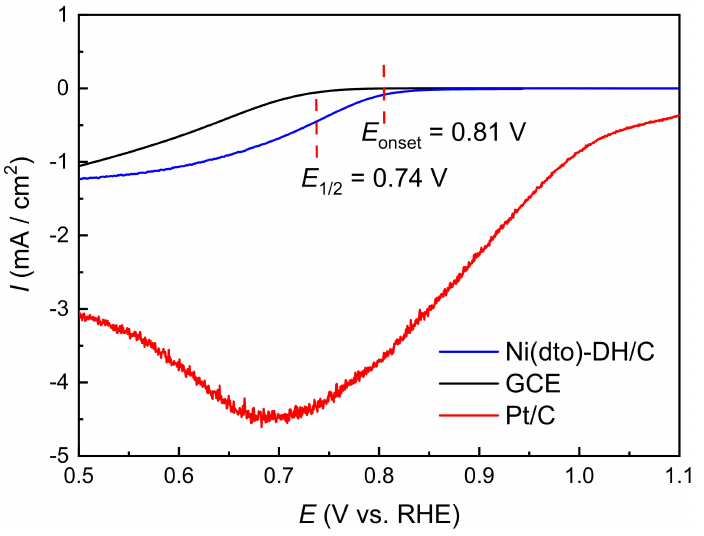
Figure 4. The LSV curves of the Ni(dto)-DH/C electrode in comparison with the bare GC-RDE and 40% Pt/C electrode performed in an oxygen-saturated 1 M KOH solution at an electrode rotation speed of 1600 rpm and a scan rate of 5 mV/s in the current per geometrical area of the